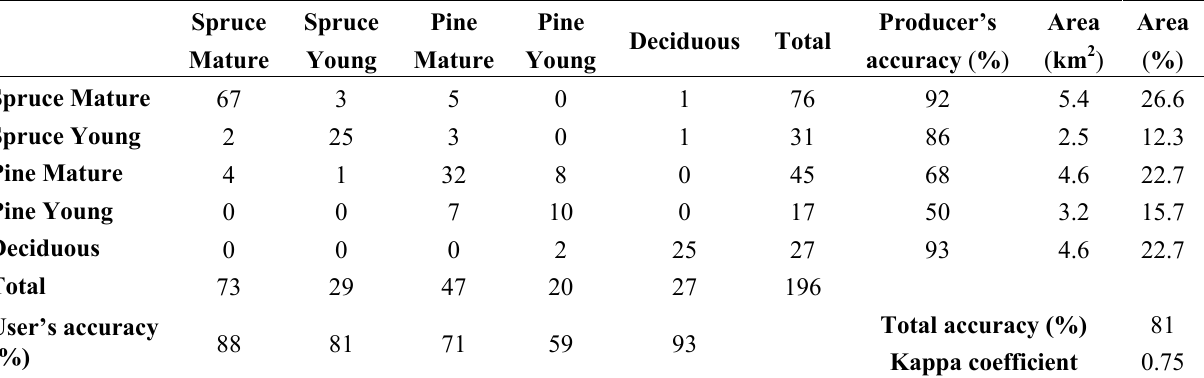
Table 2. Accuracy assessment for SPOT-5 image, using classification metrics from Congalton [24].